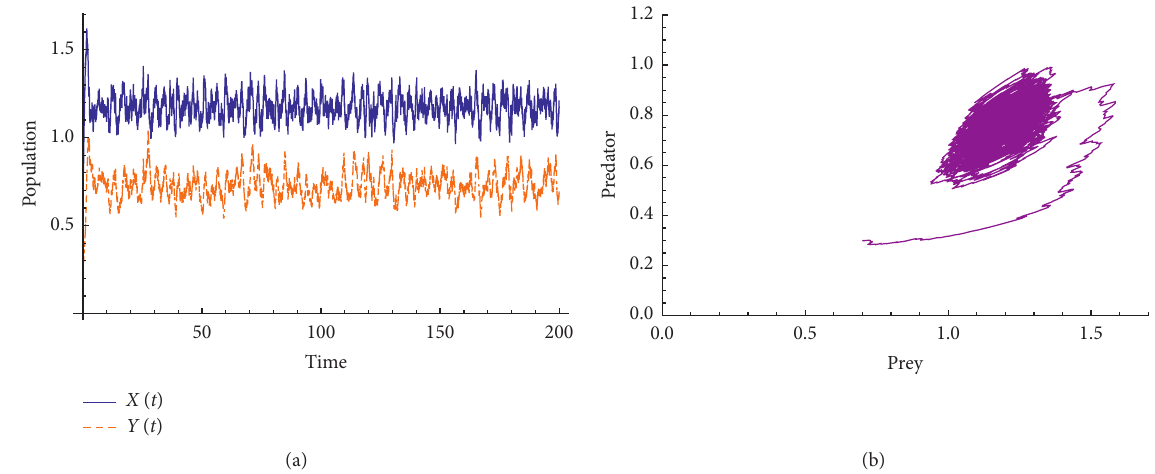
Figure 3: Dynamics model (6a) and (6b) when ( σ � 1 . 0 ) : (a) time series; (b) phase